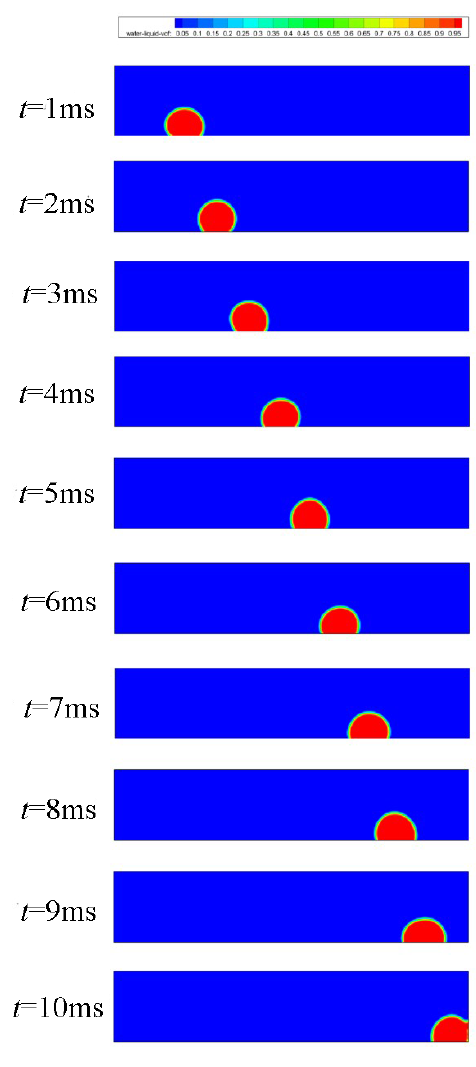
Figure 12. Water droplet dynamics in the flow channel with modified GDL surface.